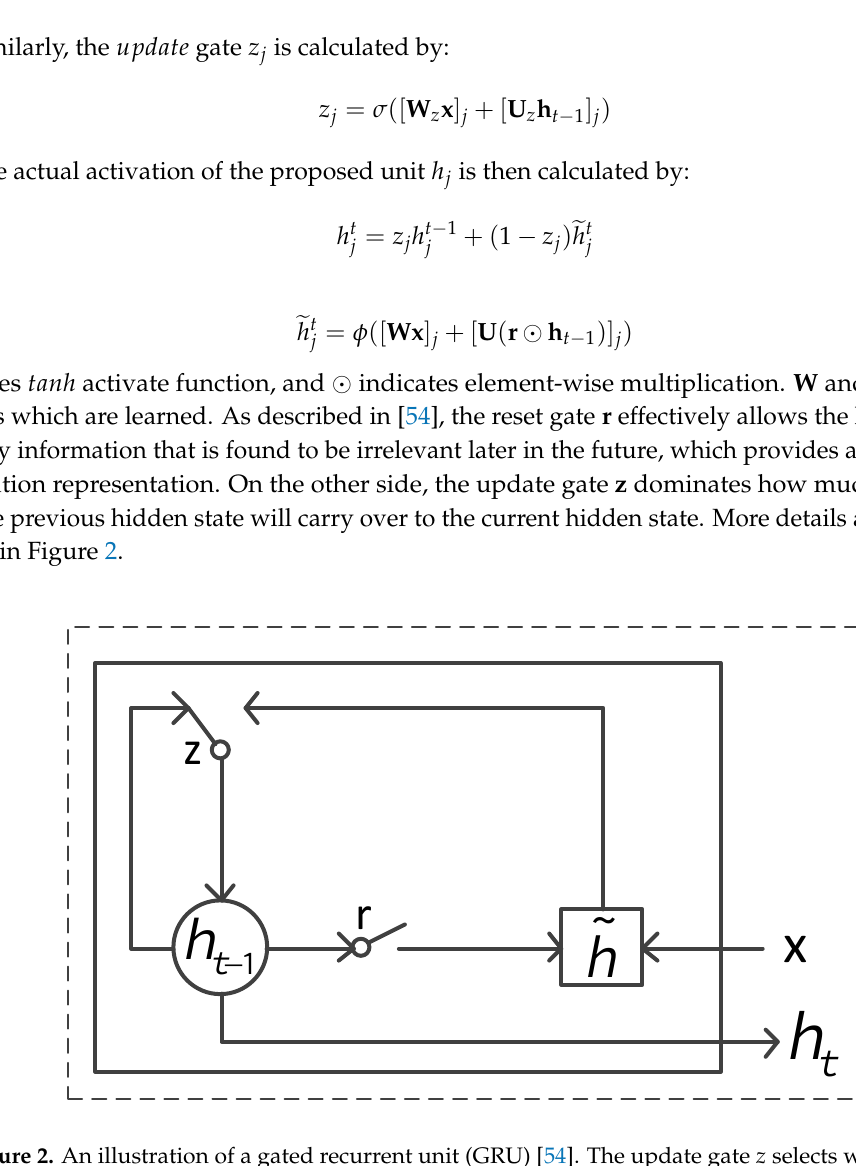
Figure 2. An illustration of a gated recurrent unit (GRU) [54]. The update gate z selects whether the hidden state h t is to be updated with a new hidden state (cid:101) h . The reset gate r decides whether the previous hidden state h t − 1 is